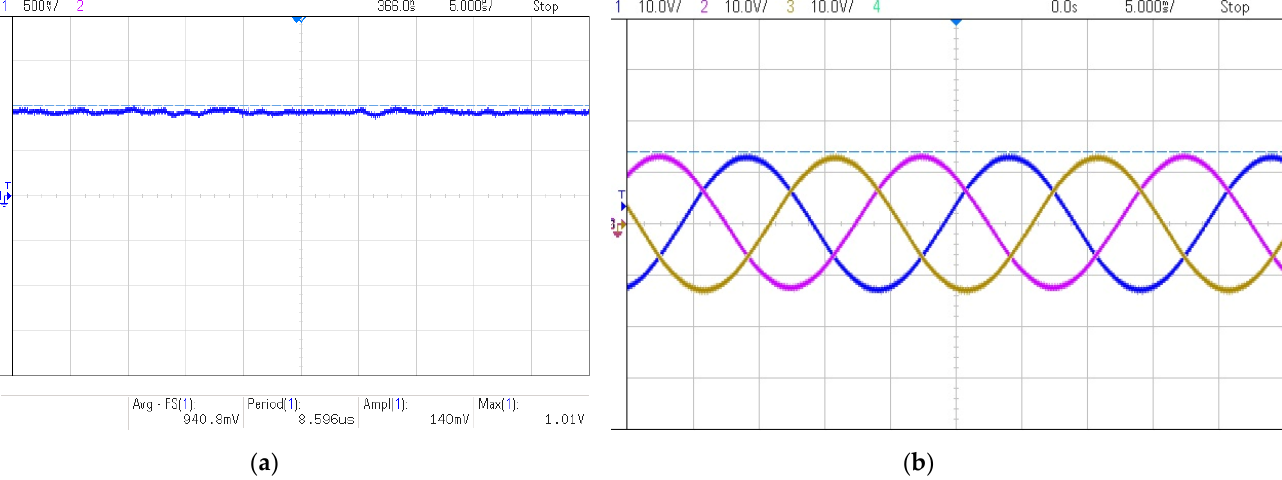
Figure 27. The experimental voltage waveforms of the FS-PDCC-based three-phase VSI: ( a ) The output of the voltage sensor IC ACPL-C870, ( b ) the experimental output voltage waveform of the predictive current-controlled three-phase VSI (Scale: Y-axis: 10 V/div; X-axis: 5 ms/div).